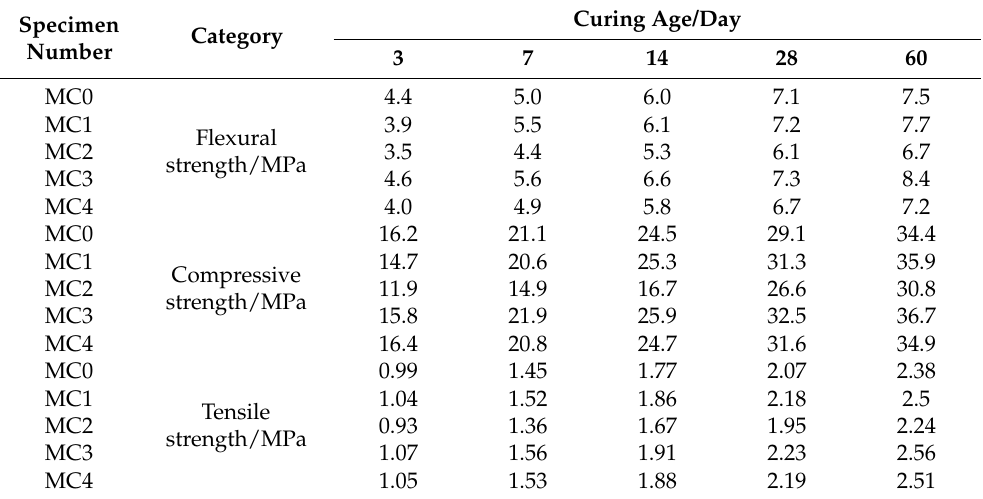
Table 5. Mechanical properties under various curing ages .